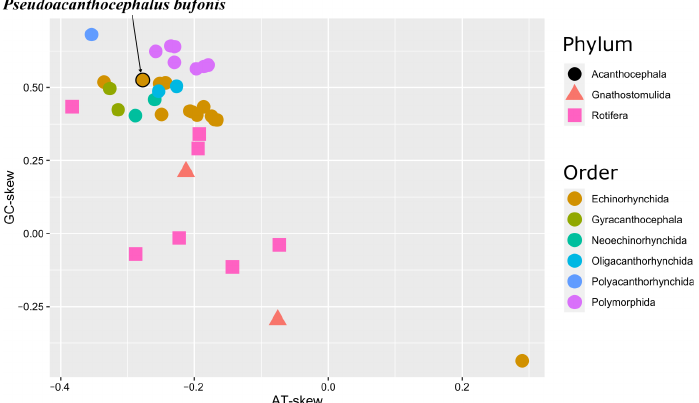
Figure 3. Comparison of genome-wide nucleotide skews among Acanthocephala, Gnathostomulida, and Rotifera. Species of Acanthocephala are coloured according to their taxonomic placement at the Order level.